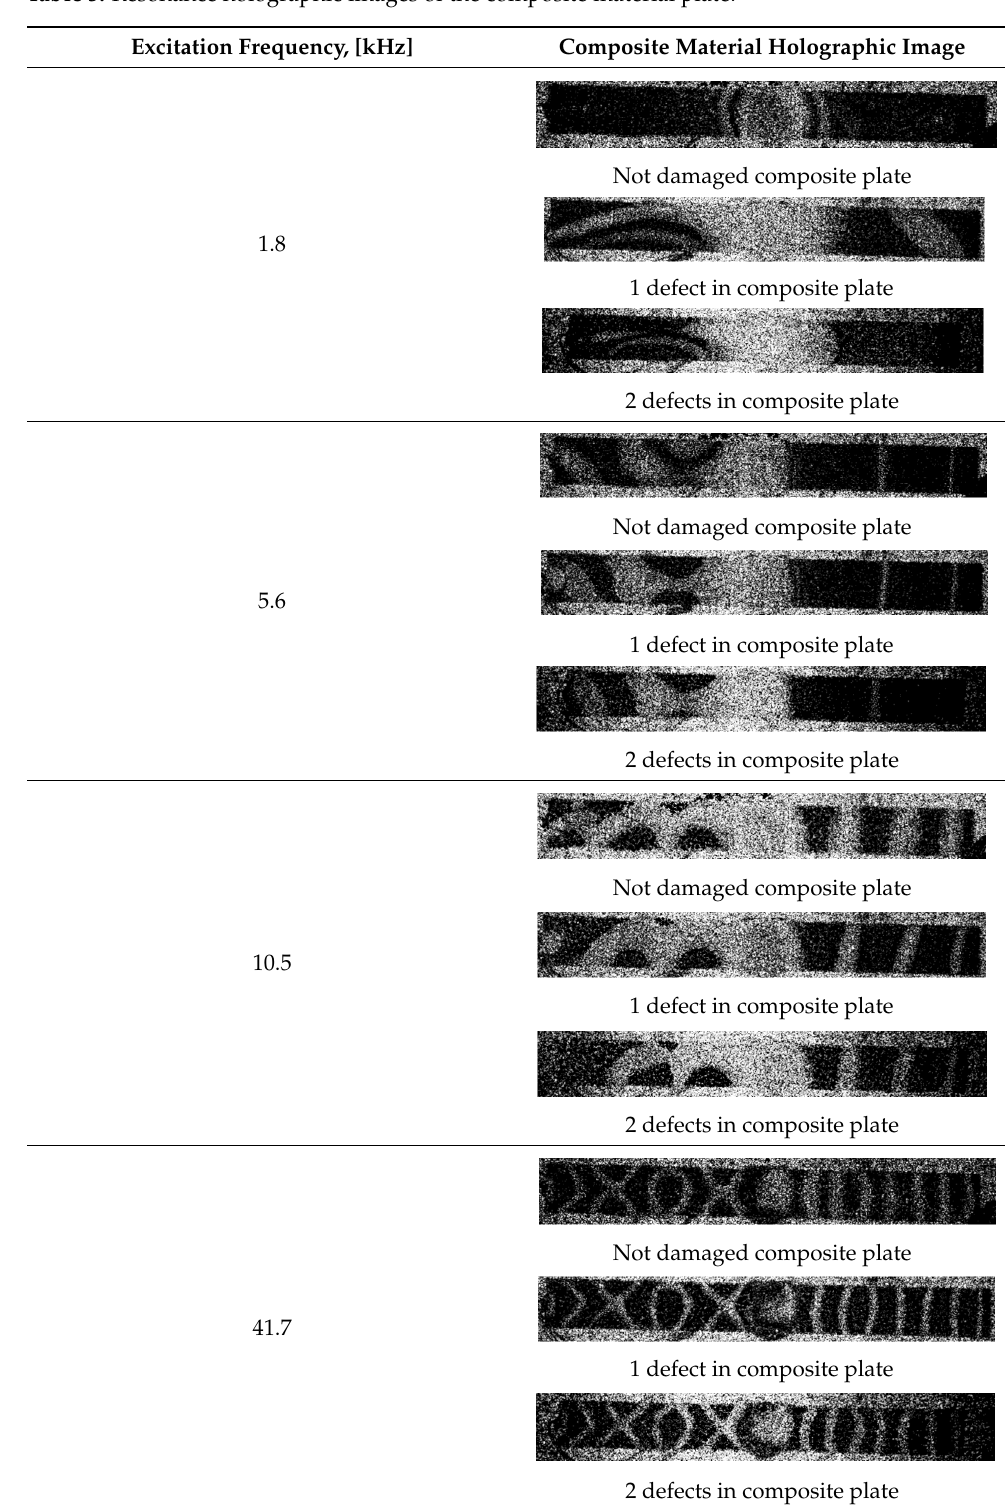
Table 3. Resonance holographic images of the composite material plate.